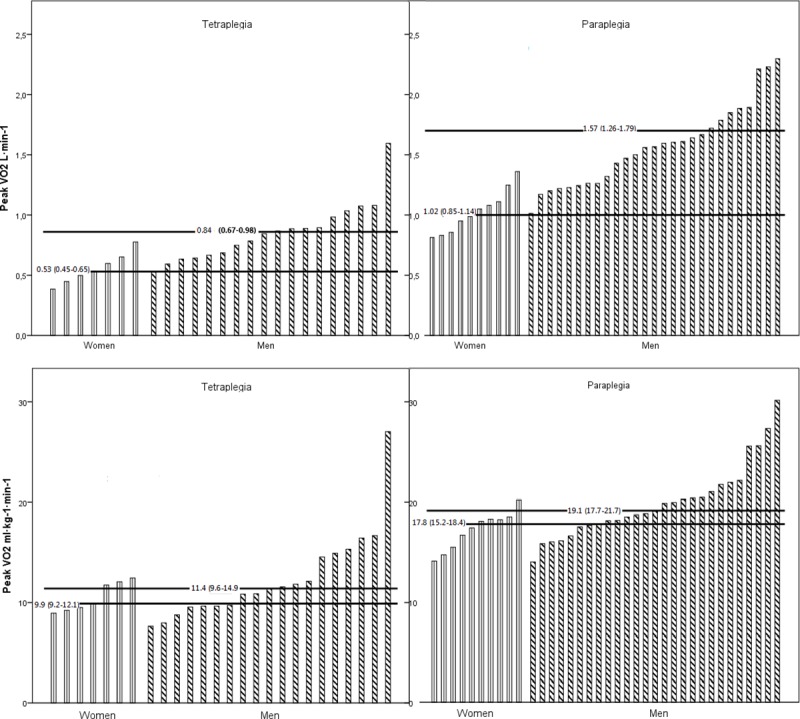
a. Individual absolute VO2peak L·min-1 (IQR) values and group median for tetraplegic (left) and paraplegic (right) women and men. b. Individual relative VO2peak (ml·min-1·kg-1) values and group median for tetraplegic (left) and paraplegic (right) women and men. * Significant difference between men/women, p&<0.002 ** Significant difference between men/women, p&<0.03.